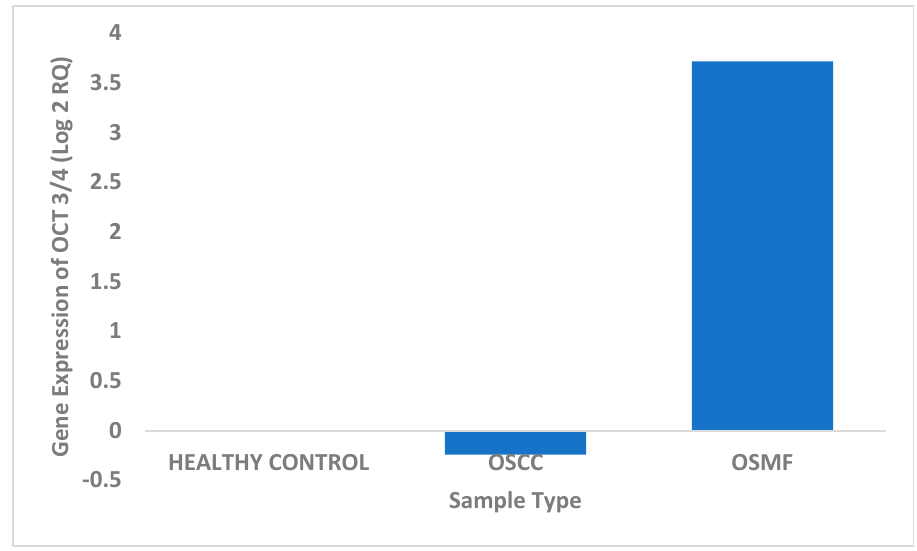
Table 4. Expression levels of OCT 3/4 in OSCC, OSMF and healthy control samples.